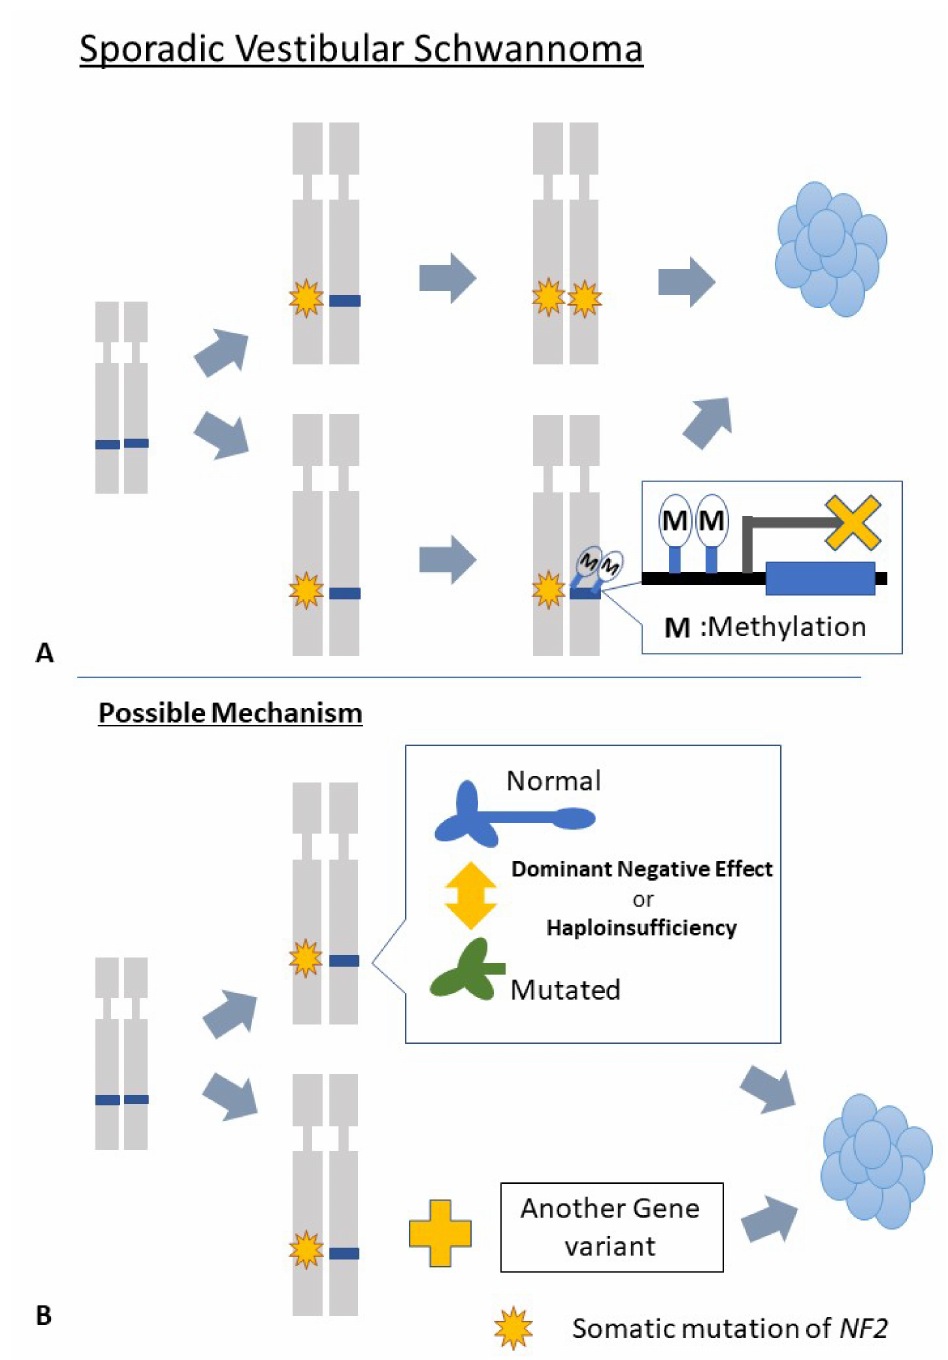
Figure 4. Molecular mechanism of the tumorigenesis in sporadic vestibular schwannoma. In sporadic vestibular schwannoma, somatic mutation of the NF2 gene is essential for tumor development, but the mechanism has not been fully understood in contrast to neurofibromatosis cases. In many cases, biallelic NF2 gene variants lead to tumorigenesis ( A ); however, other possible mechanisms have been suggested ( B